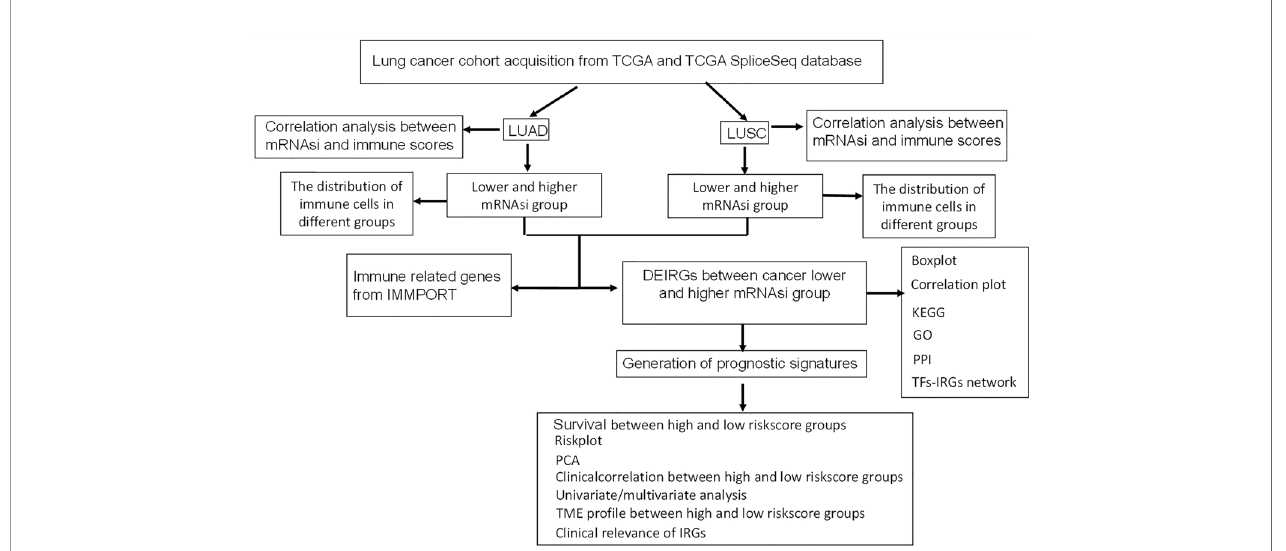
FIGURE 1 | Flow chart for identi fi cation of mRNAsi-related immune signatures in LUAD and